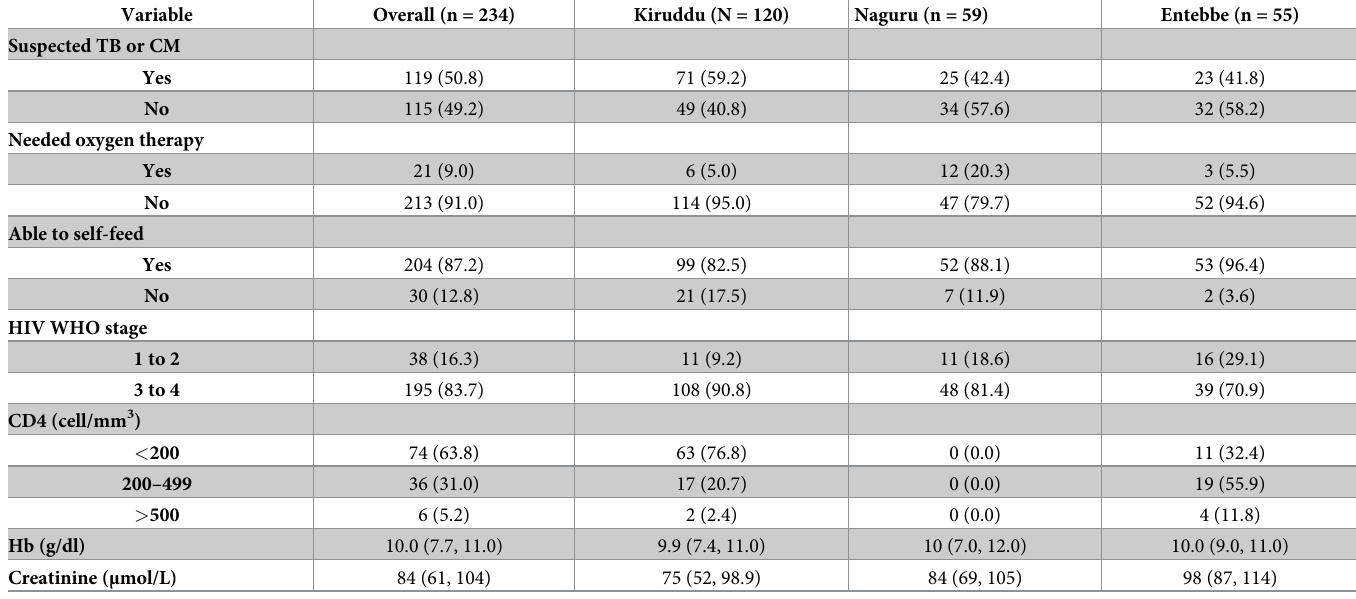
Table 2. Baseline clinical characteristics of hospitalized patients with a recent HIV diagnosis stratified by study